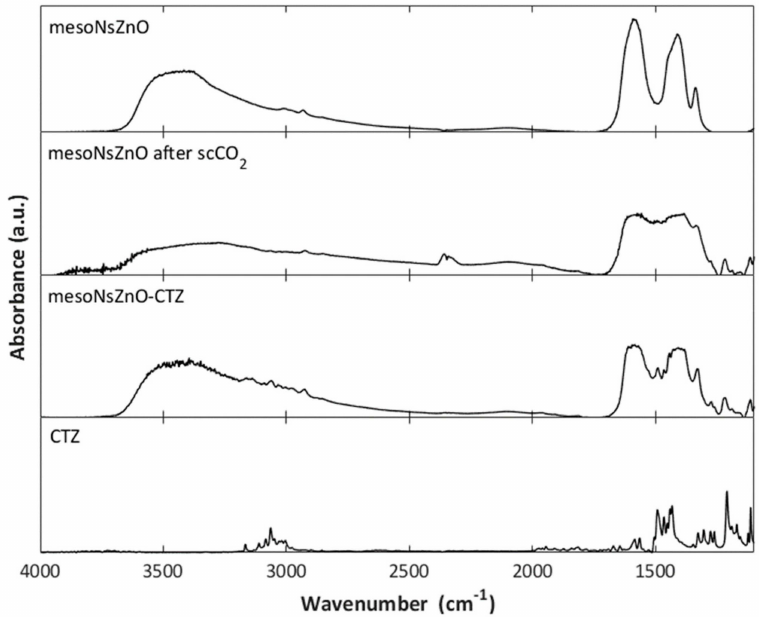
Figure 9. FTIR spectra: MesoNsZnO carrier, mesoNsZnO after the scCO 2 treatment (100 ◦ C, 25 MPa, 12 h), mesoNsZnO-CTZ system,